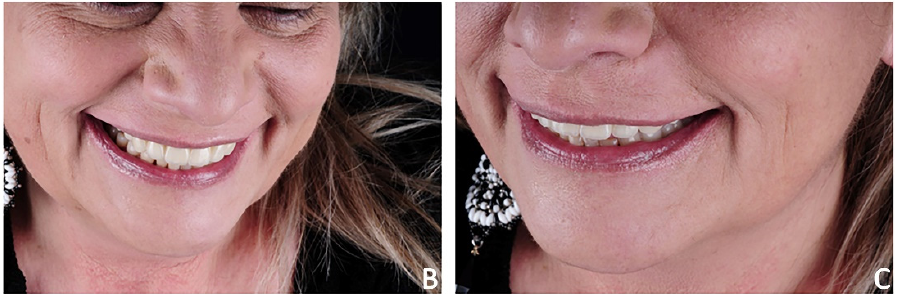
Figure 21. Case 3. Post-treatment smile aesthetics. ( A ) frontal smile view; ( B ) 3/4 right smile view; ( C ) 3/4 left smile view .